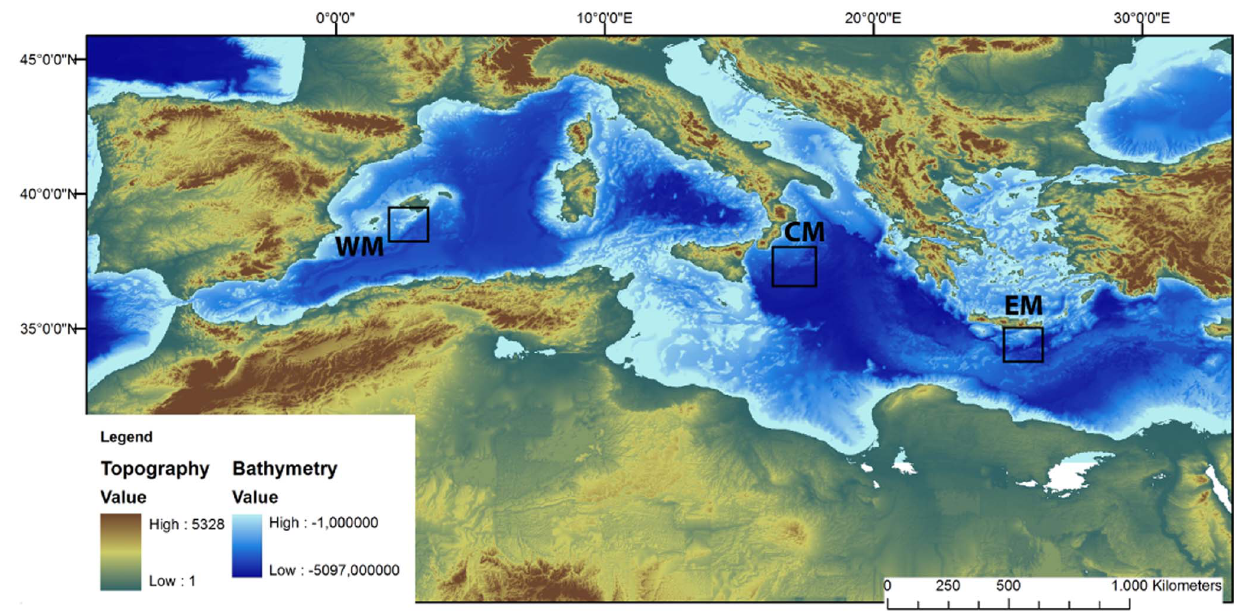
Figure 1. Bathymetric map of the study area. Map of the Mediterranean Sea, with bathymetry and showing the location of sampling sites. WM: Western Mediterranean (southern Balearic), CM: Central Mediterranean (western Ionian), EM: Eastern Mediterranean (south of Crete).